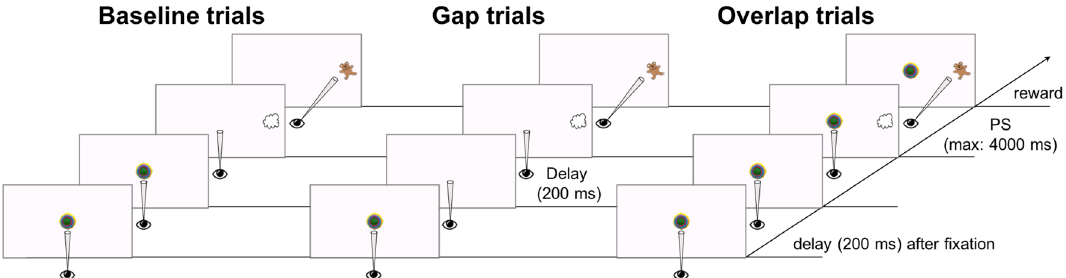
Figure 3. Stimulus sequence for experimental trials in the Gap-Overlap Task. Stimuli drawn to scale. Every trial started with the central stimulus onset and were followed by the presentation of the peripheral stimuli (PS).